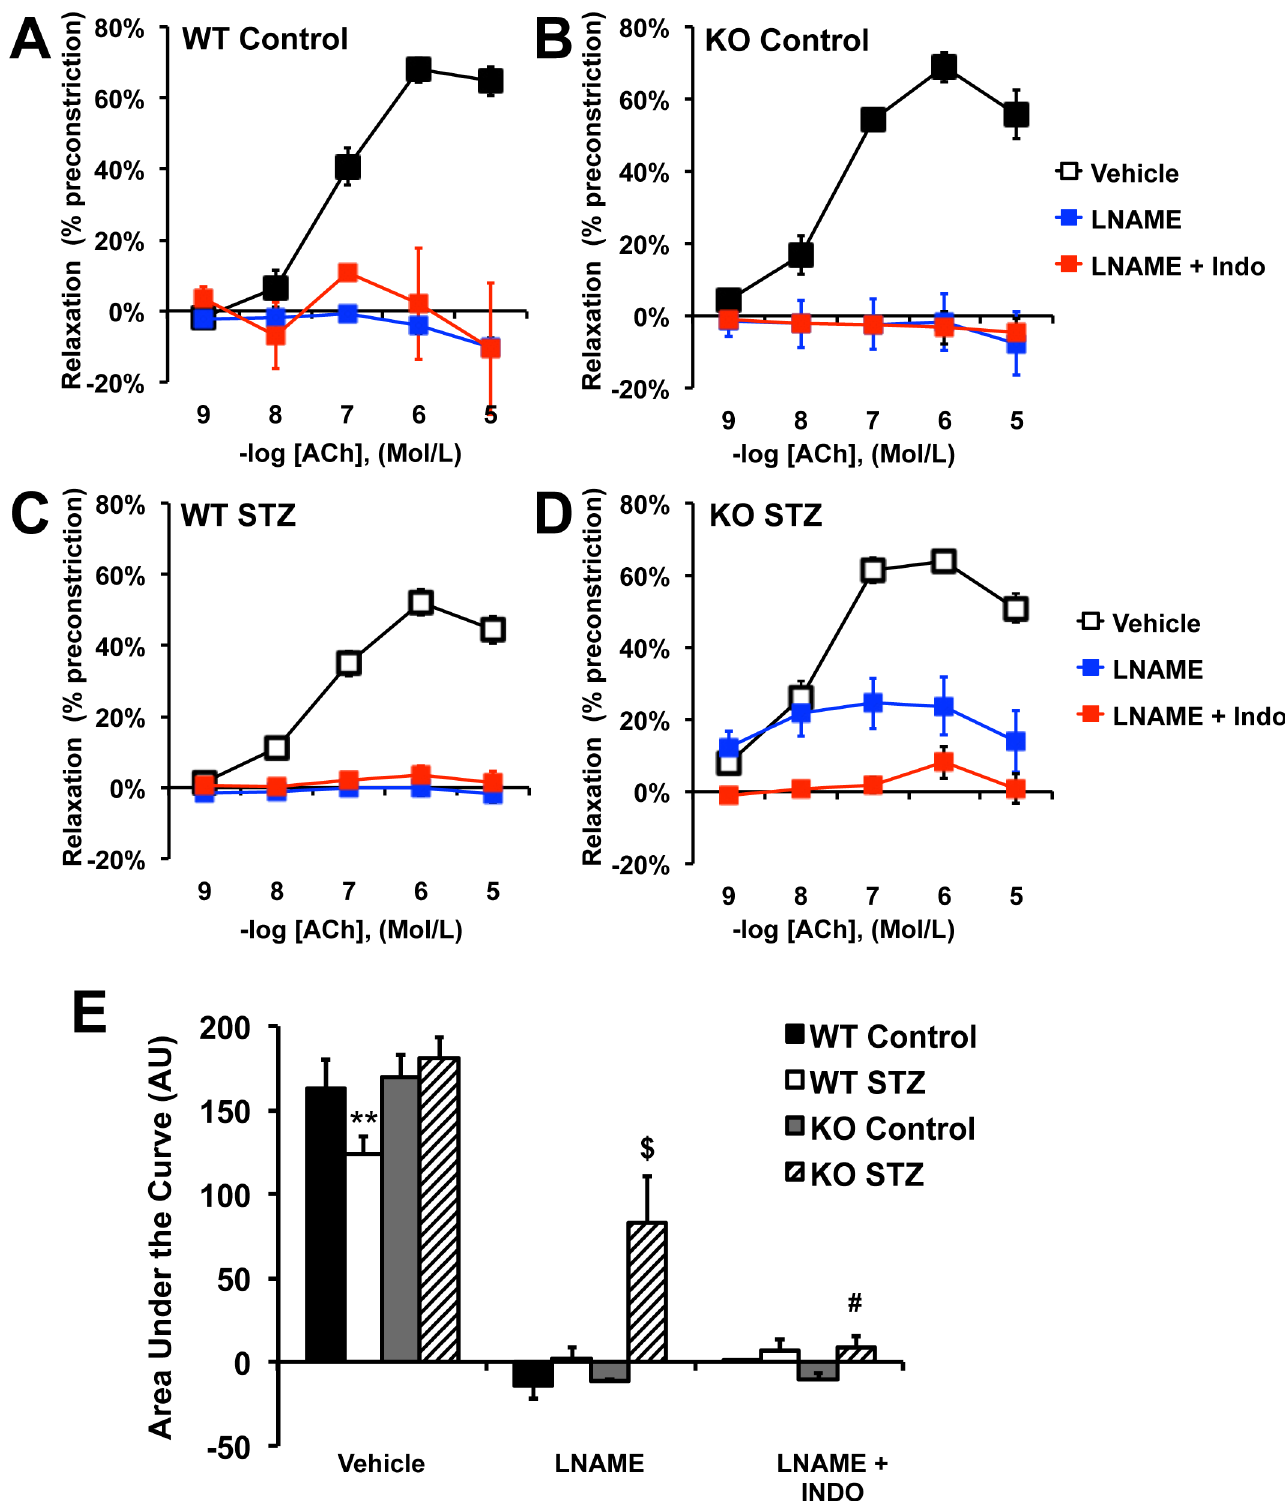
Fig 2. Cyclooxygenase derivatives preserve endothelial function in PTP1B KO mice treated with STZ. A-D: Concentration response curves to acetylcholine (ACh) conducted in the presence or not of the NOS inhibitor L-NAME (10 μ M) or the cyclooxygenases inhibitor indomethacin (Indo,10 μ M). E: Quantification of the area under the curve for each concentration response curve. Data are mean ± SEM, n = 6 per group, ** p < 0.001 vs . Control within the same group, $ p < 0.05 vs . vehicle, # p < 0.05 vs . L-NAME. doi:10.1371/journal.pone.0126866.g002 PLOS ONE | DOI:10.1371/journal.pone.0126866 May 14,